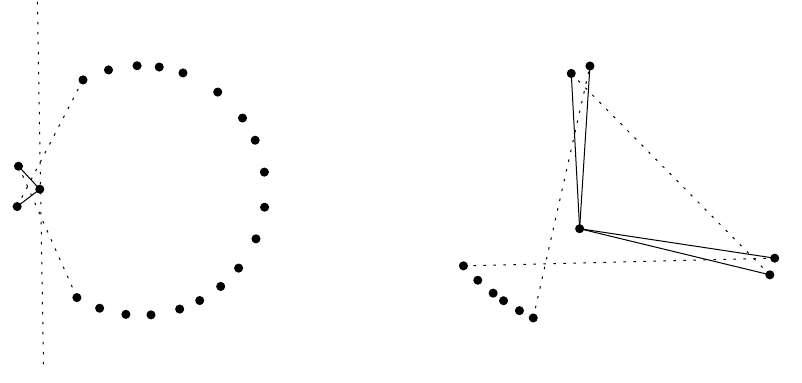
Fig. 7: Removing two avoidable edges disallows a triangulation (left), and removing four avoidable edges disallows a pseudo-triangulation